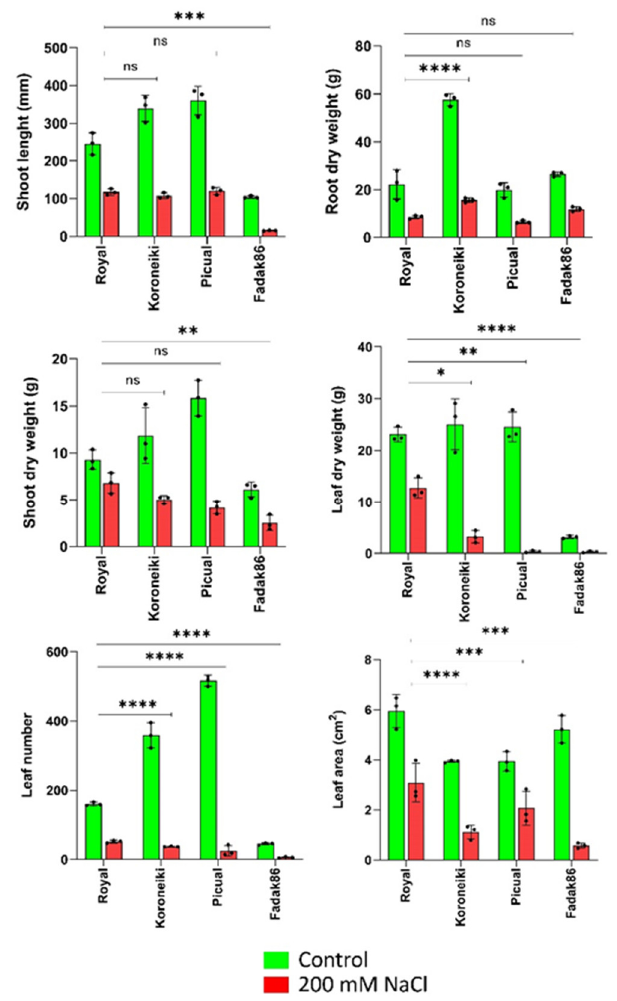
Figure 1. Plant growth measurements of four cultivars at 0 (green) and 200 mM NaCl (red), after 240 DATS of salt stress. Bars represent means ± SD of three replicates. Asterisks show **** p = 0.000, *** p < 0.001, ** p < 0.01 and * p < 0.05 and ns represents not significant values.